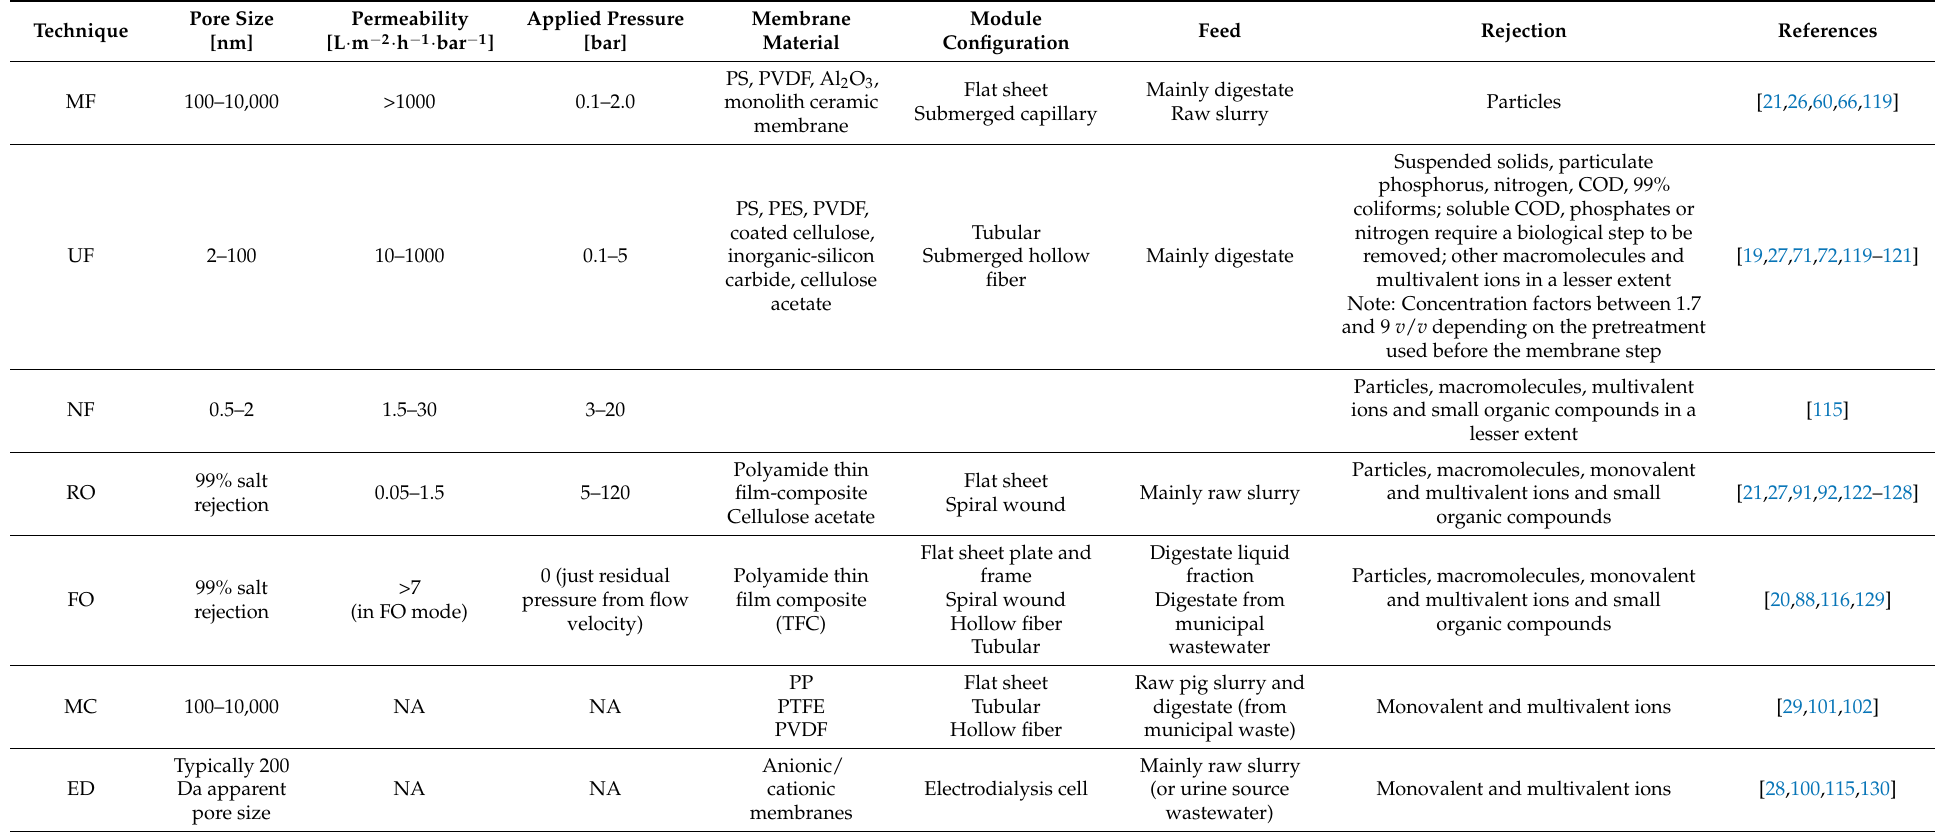
Table 6. Classification of the main commercial membranes applied for separation of manure and digestate liquid fractions